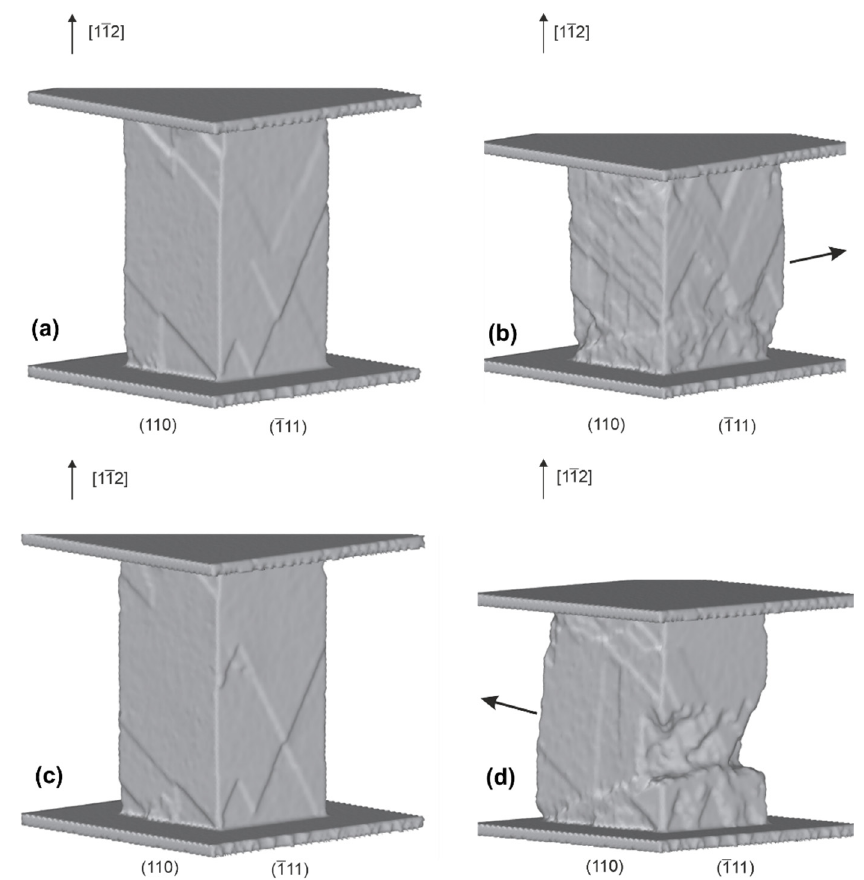
(cid:2) (cid:3) 112 -single crystals, ε = 7% ( a , c ), 24% ( b , d ) (the (cid:0) (cid:1) (cid:0) (cid:1) 110 ; ( c , d ) the free lateral face 111